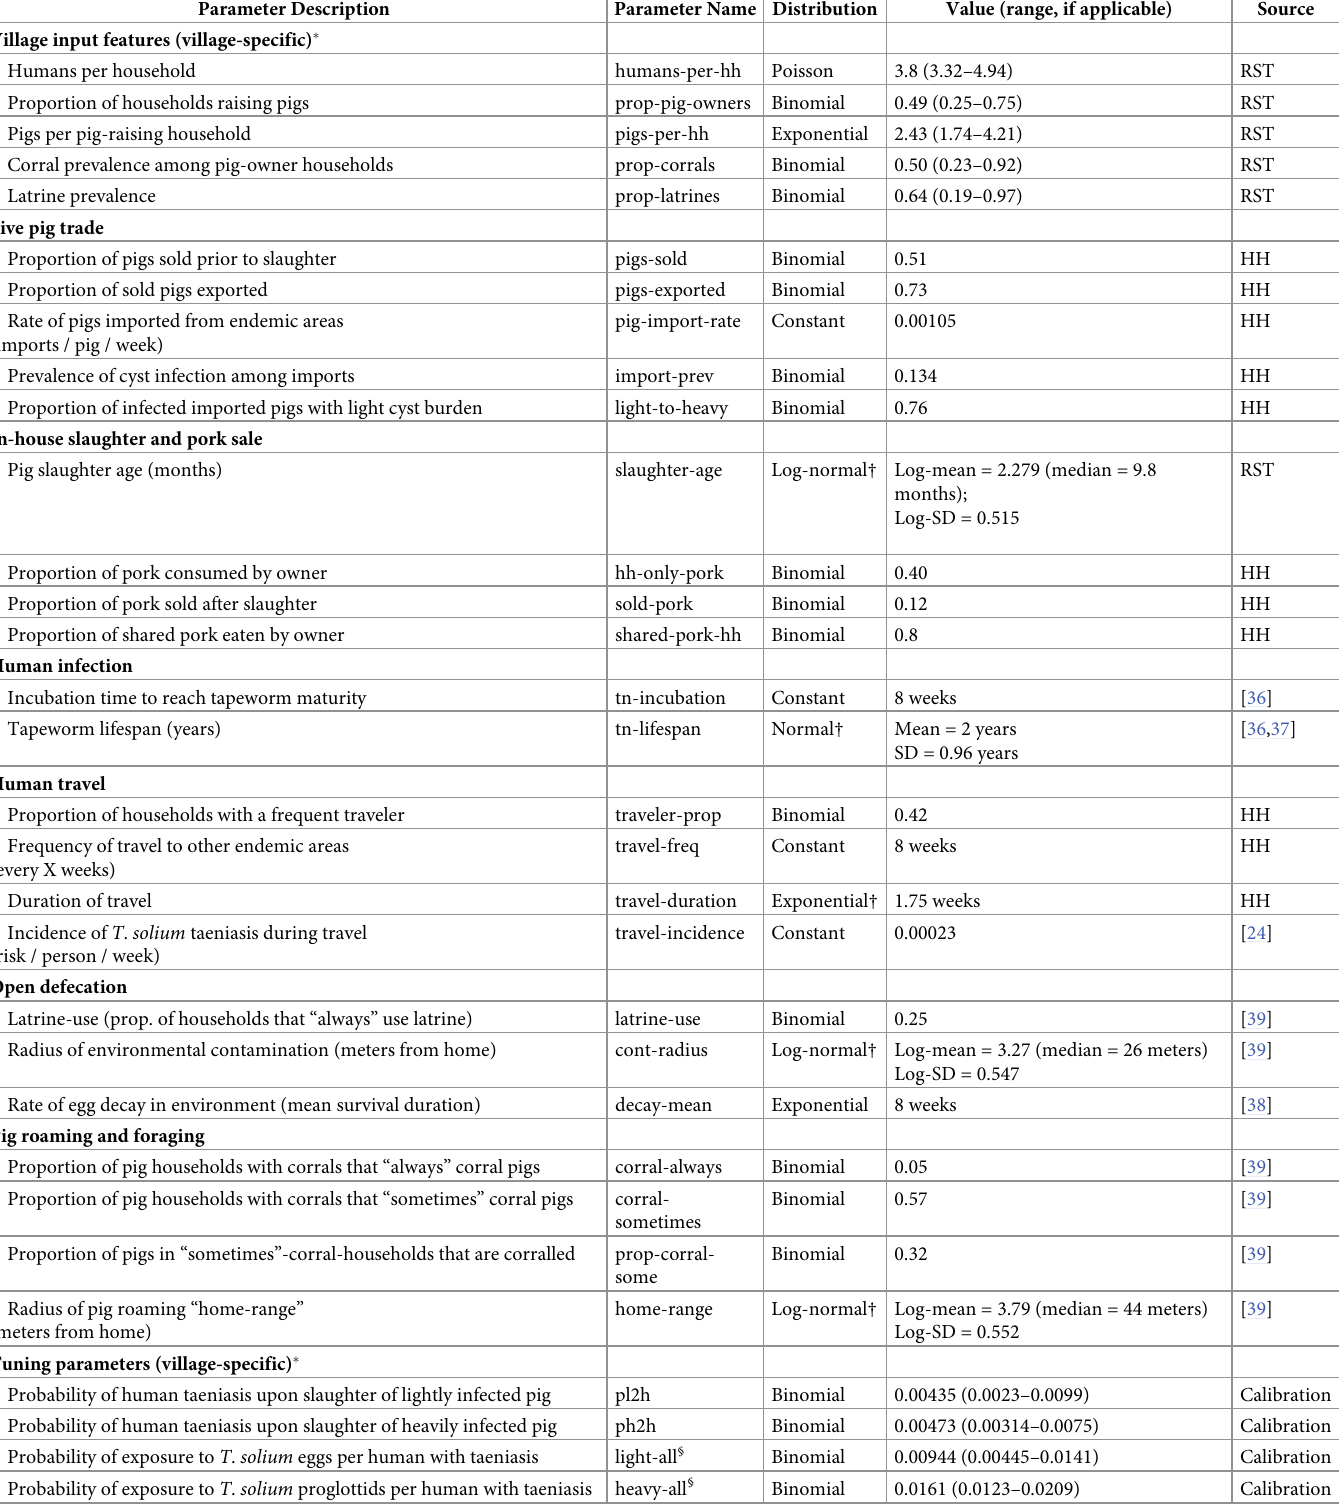
Table 1. CystiAgent model